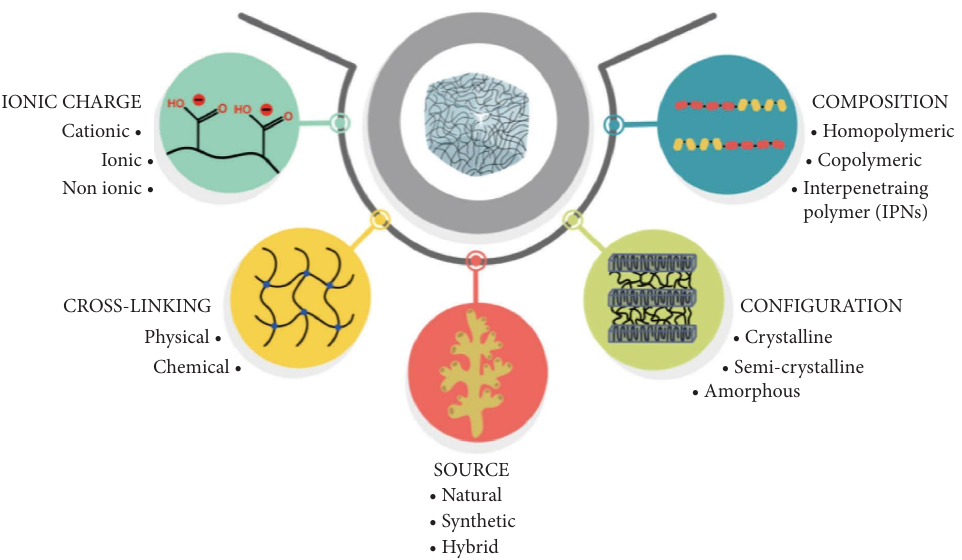
Figure 2: Hydrogel